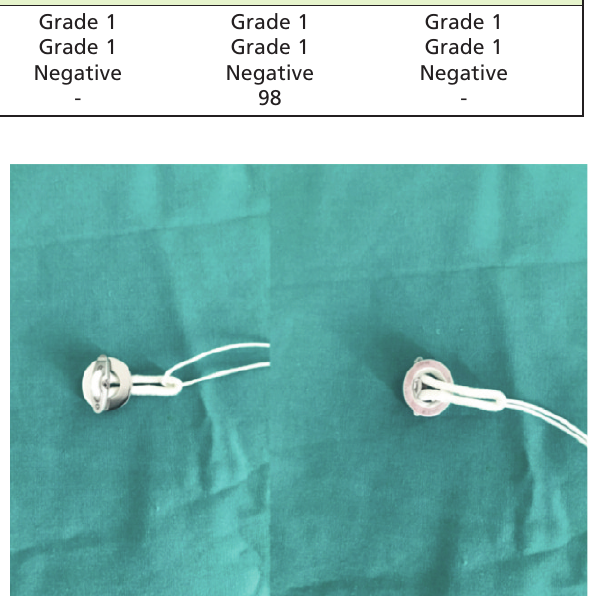
Images showing position of washer in relation with the Fig. 2: endobutton.